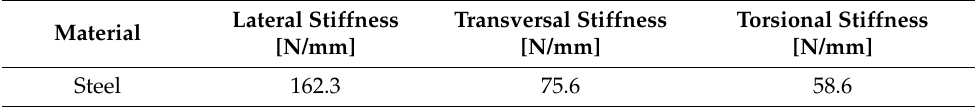
Table 7. Stiffness of conventional steel hood (geometrically identical with “A”